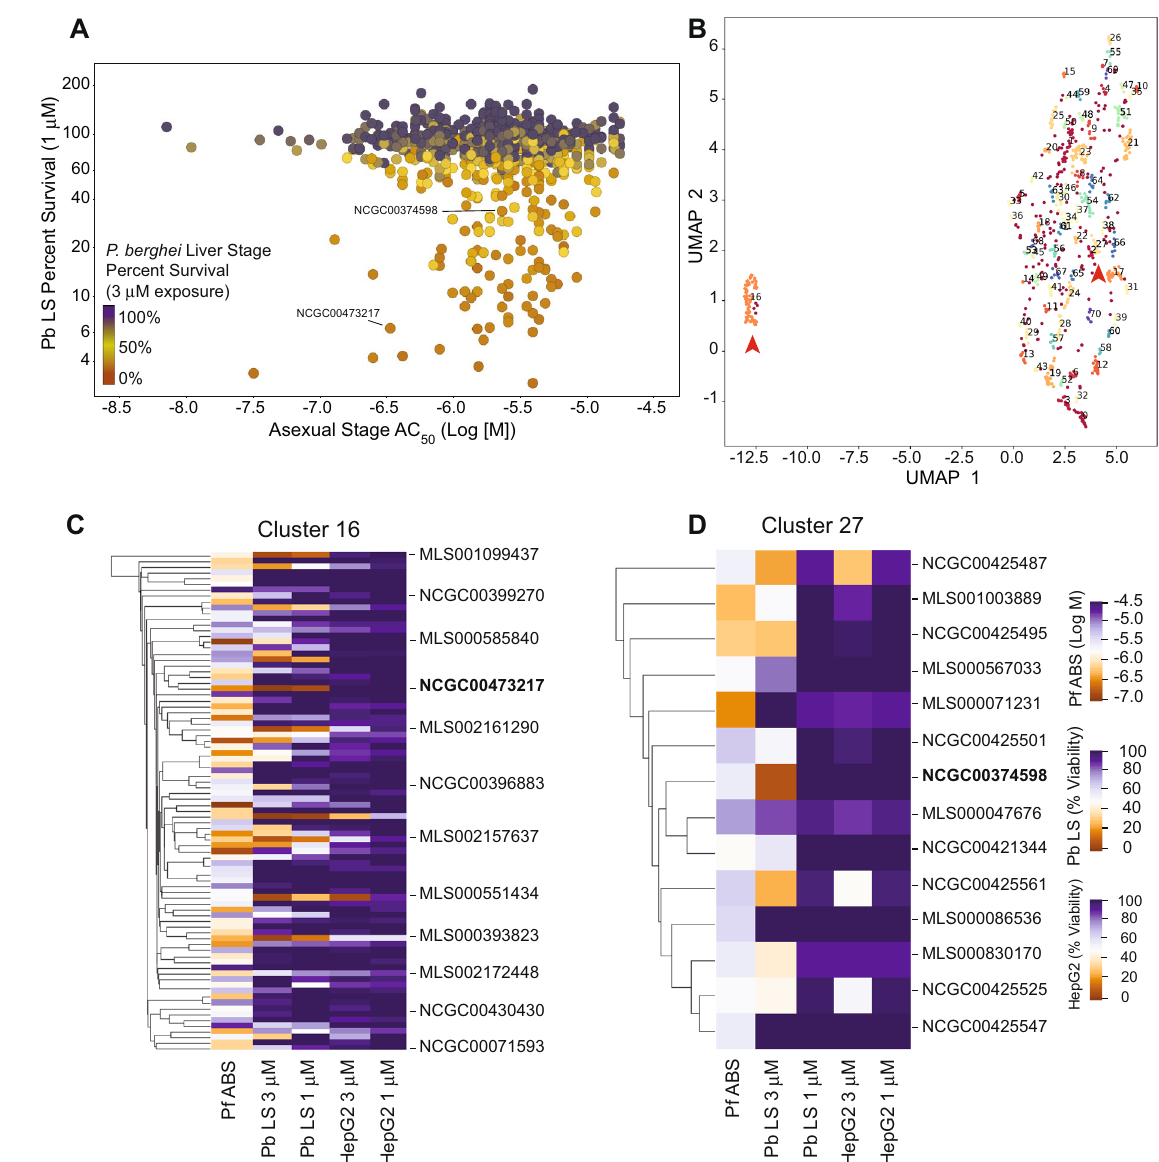
Figure 2. Stage-specific activity and chemical relatedness of compounds active against P. falciparum ABS and P. berghei liver stage parasites. ( A ) Multidimensional scatterplot of P. berghei liver stage activity compared to P. falciparum asexual stage inhibition. P. berghei liver stage percent survival (Y-axis) was assessed at a single 1 μM concentration. The color denotes the survival in the liver stage assay at a single 3 μM concentration (red, 0% survival; black 100% survival). P. falciparum asexual activity AC 50 value (X-axis) was determined from qHTS 72 h in vitro growth proliferation assays. ( B ) Uniform manifold approximation and projection (UMAP) of structural similarity, based on the Tanimoto coefficient, for the 994 compounds active against P. falciparum ABS parasites and screened for activity against P. berghei liver stages. Clusters 16 and 27 are highlighted with red arrowheads. ( C , D ) Depiction of clusters 16 (including the thiadiazine hit NCGC00473217) and 27 (including the pyrimidine azepine hit NCGC00374598). The compounds are clustered by Tanimoto similarity, with heat map representation of the ABS activity against P. falciparum Dd2-B2 (shown as Log [M] concentration values), activity against P. berghei liver stages (Pb LS), and toxicity against HepG2 cells, tested at both 3 μM and 1 μM and represented as percentage viability. Heat maps were generated on the UMAP data projection using the software DBSCAN (version 0.24.0; https ://sciki t-learn .org/stabl e/modul es/gener ated/sklea rn.clust er.DBSCA N.html; see “Methods”